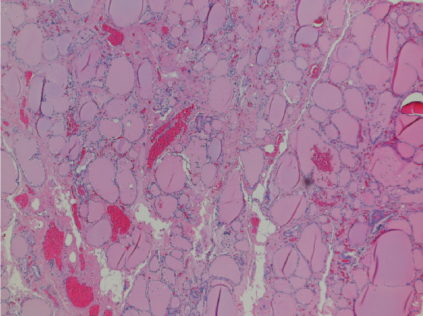
Figure 2: Nodular hyperplasia with degenerative changes, a lim- ited lymphocytic thyroiditis and adipose metaplasia of thyroid stroma. Some signs of bleeding and previous bleeding are seen (Hematoxylin-eosin, × 40).